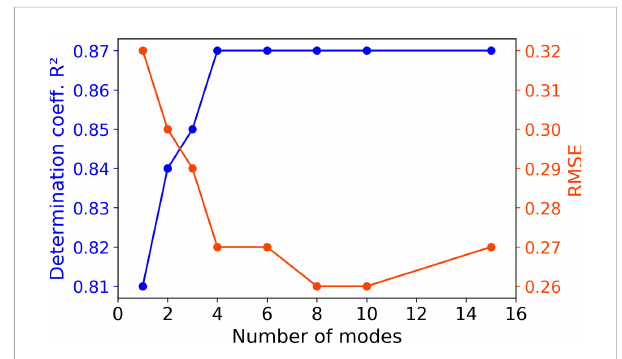
FIGURE 4 Performance evolution according to the number of modes of the CNN MMi models. Metrics are computed over the [1998-2001] validation period during which model parameters are